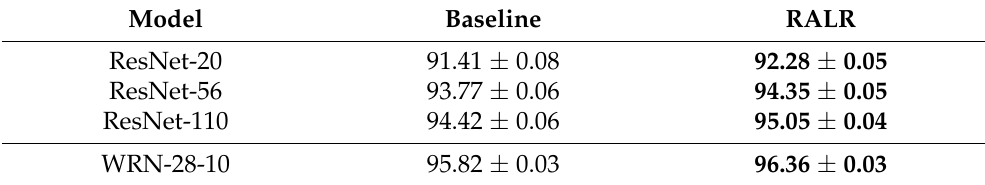
Table 1. Validation accuracy (%) over different architectures on CIFAR-10.